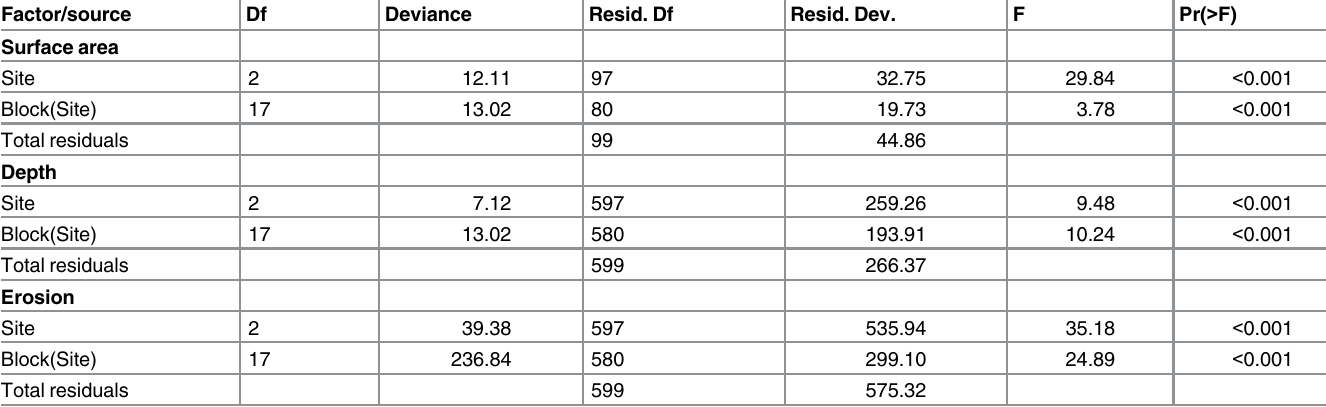
Table 2. Analysis of deviance table from GLM of microborer colonization of calcite blocks at each of the three study sites. Df, degrees of freedom; Resid. Df, Residual degrees of freedom; Resid. Dev., Residual deviance. Factor/source Df Deviance Resid.